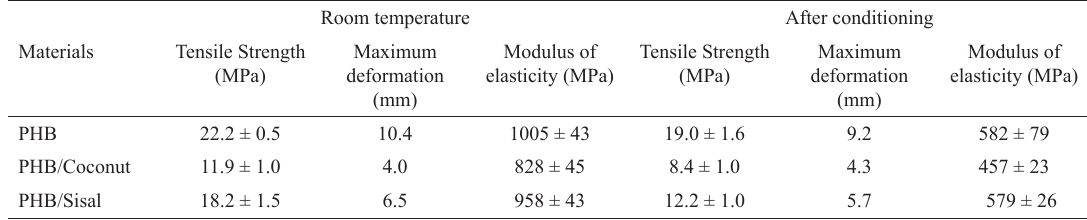
Table 6: Maximum tensile strength (MPa), maximum deflection (mm) and the modulus of elasticity (MPa) data obtained by the average curve of the tensile test of PHB unreinforced and reinforced composites with coconut fibers and sisal fibers.